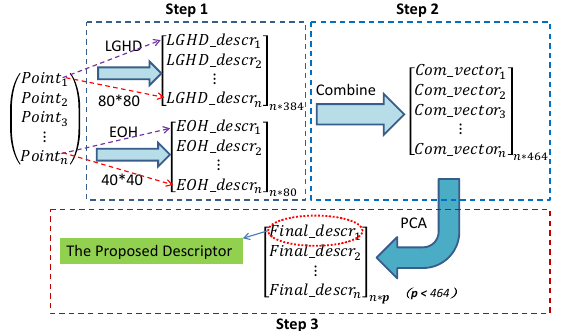
Figure 1. The flowchart of proposed